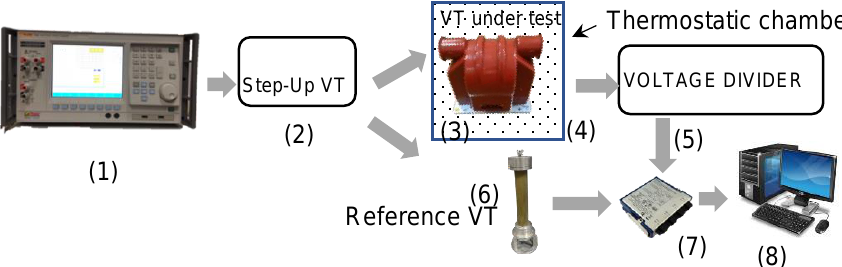
Figure 1. Experimental setup, adapted from [11], used for testing the two voltage